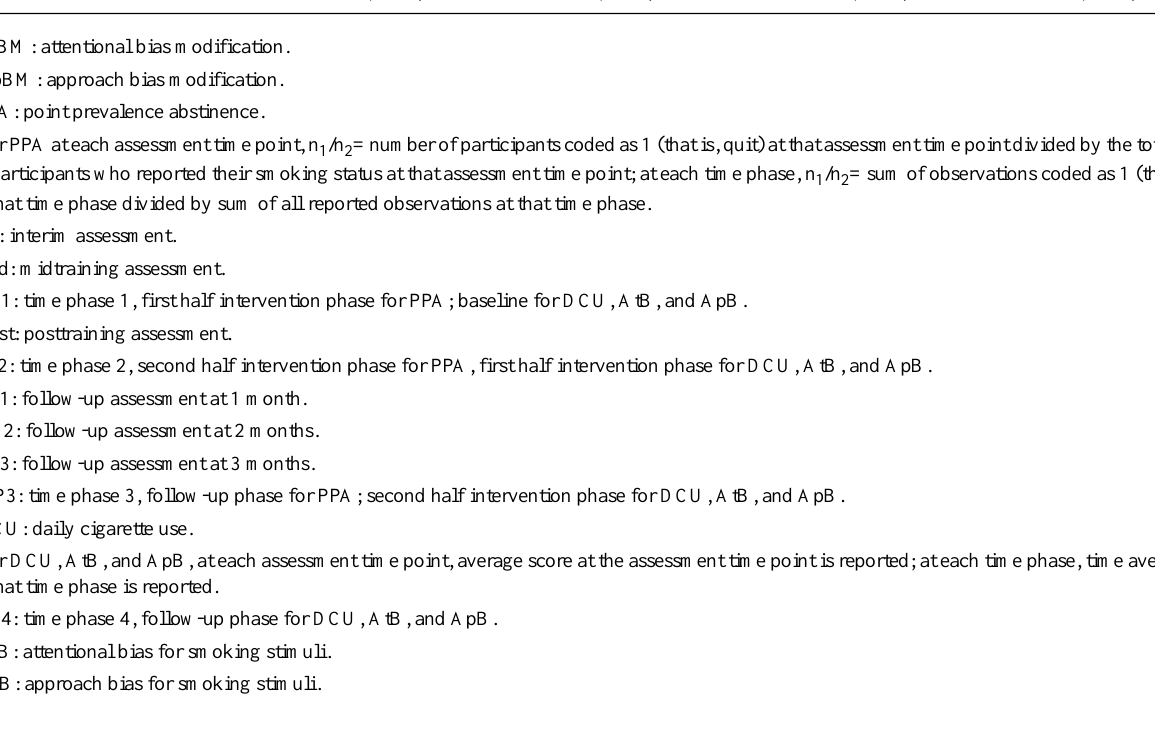
Table 4. Results of multilevel modeling